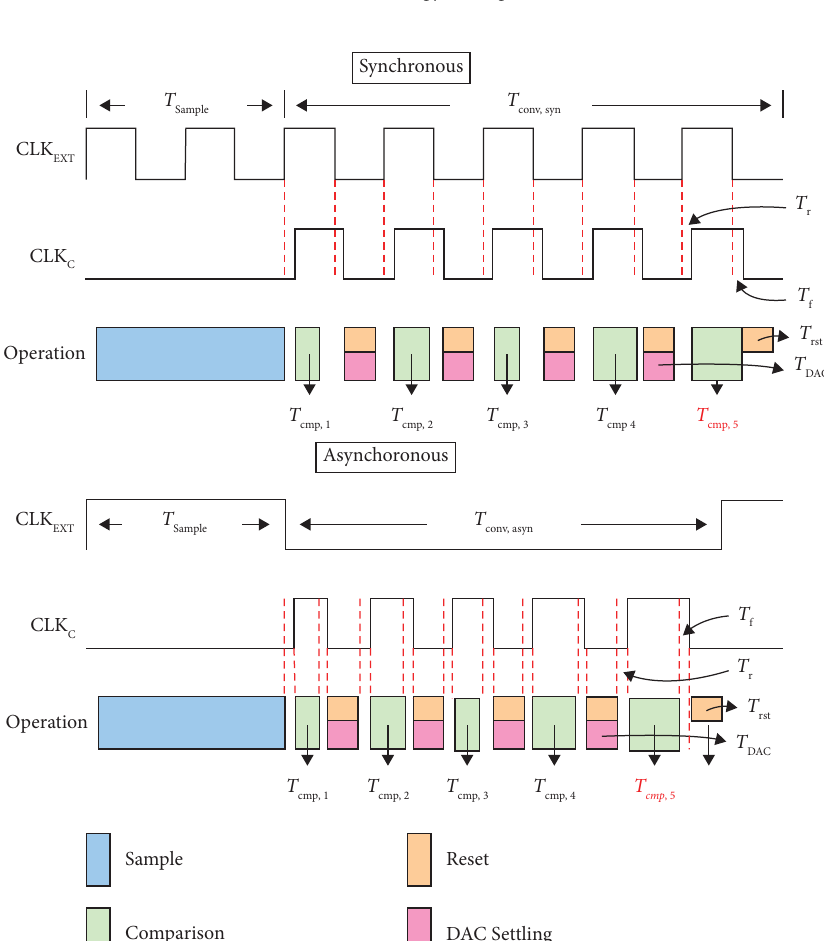
Figure 35: Timing diagram of (a) synchronous and (b) asynchronous control logic